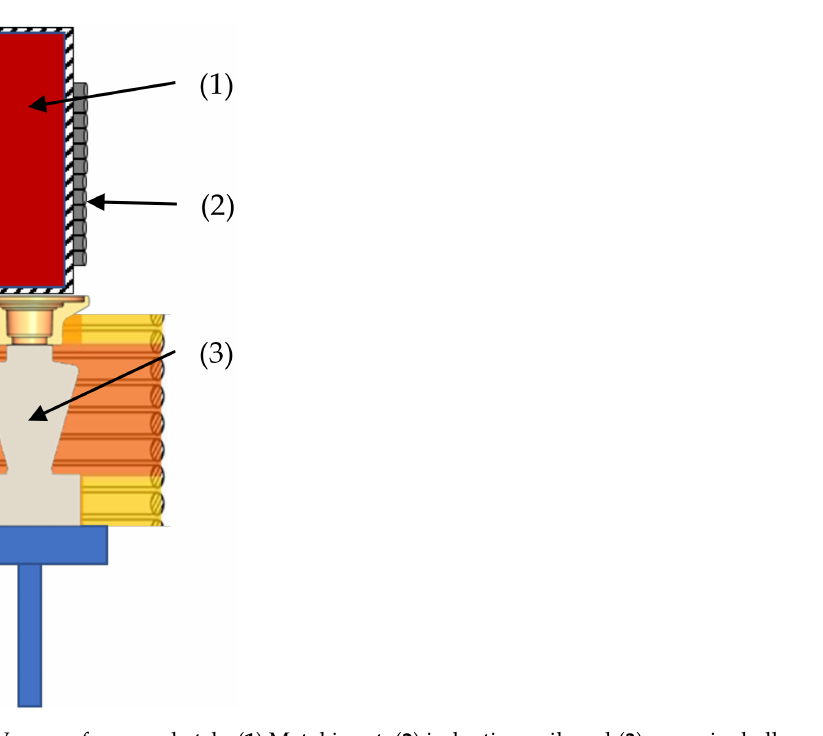
Figure 12. Vacuum furnace sketch. ( 1 ) Metal ingot, ( 2 ) induction coil, and ( 3 ) ceramic shell